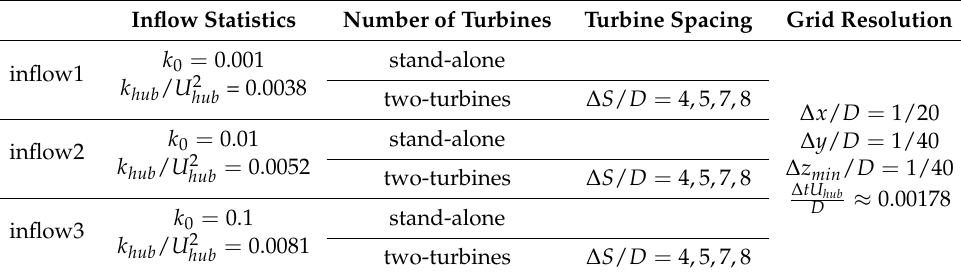
Table 1. Summary of the cases simulated in this